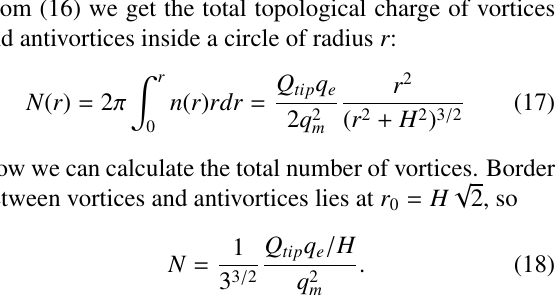
Figure 4. Configuration of vortex-antivortex system for Q tip q e / H = 240 q 2 at T = 10 − 6 q 2 . Vortex (filled circles) and m m antivortex cores (open circles) are shown. (a) Antivortex subsys- tem; vortex “nucleus” is not resolved. (b) Vortex subsystem.